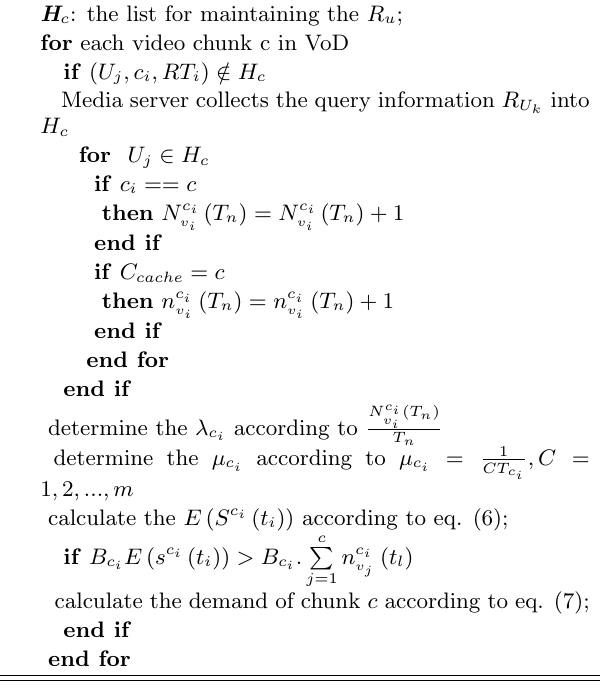
Algorithm 1 : Video Chunk Demands Estimation Algo-